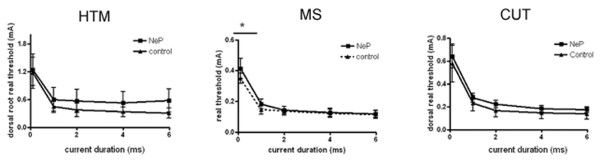
Comparison of current activation threshold of the Aβ-fiber neurons in response to stimulation of the dorsal roots, between control and neuropathic rats. Dorsal root current threshold was defined by the chronaxie curve (threshold-duration), which was determined as the minimum stimulus current to the dorsal root sufficient to evoke a soma AP with pulses of 0.1 ms, 1 ms, 2 ms, 4 ms and 6 ms duration. Figures show a reduction in the rheobase in DRG neurons in neuropathic animals. Details of abbreviations are as indicated in Figures 2 and 4.